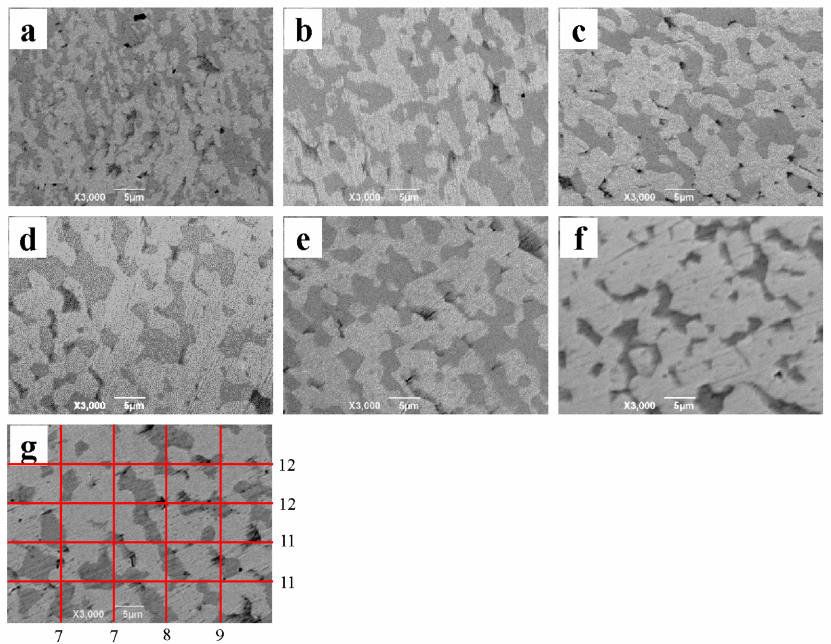
Figure 5. SEM images of W-6Ni-4Co alloys by the di ff erent sintering processes: ( a ) 1200 ◦ C, 30 min; ( b ) 1450 ◦ C 5 min; ( c )1450 ◦ C, 20 min; ( d ) 1450 ◦ C, 60 min; ( e ) 1500 ◦ C, 5 min; ( f ) 1500 ◦ C, 20 min; ( g ) 1500 ◦ C, 60 min.